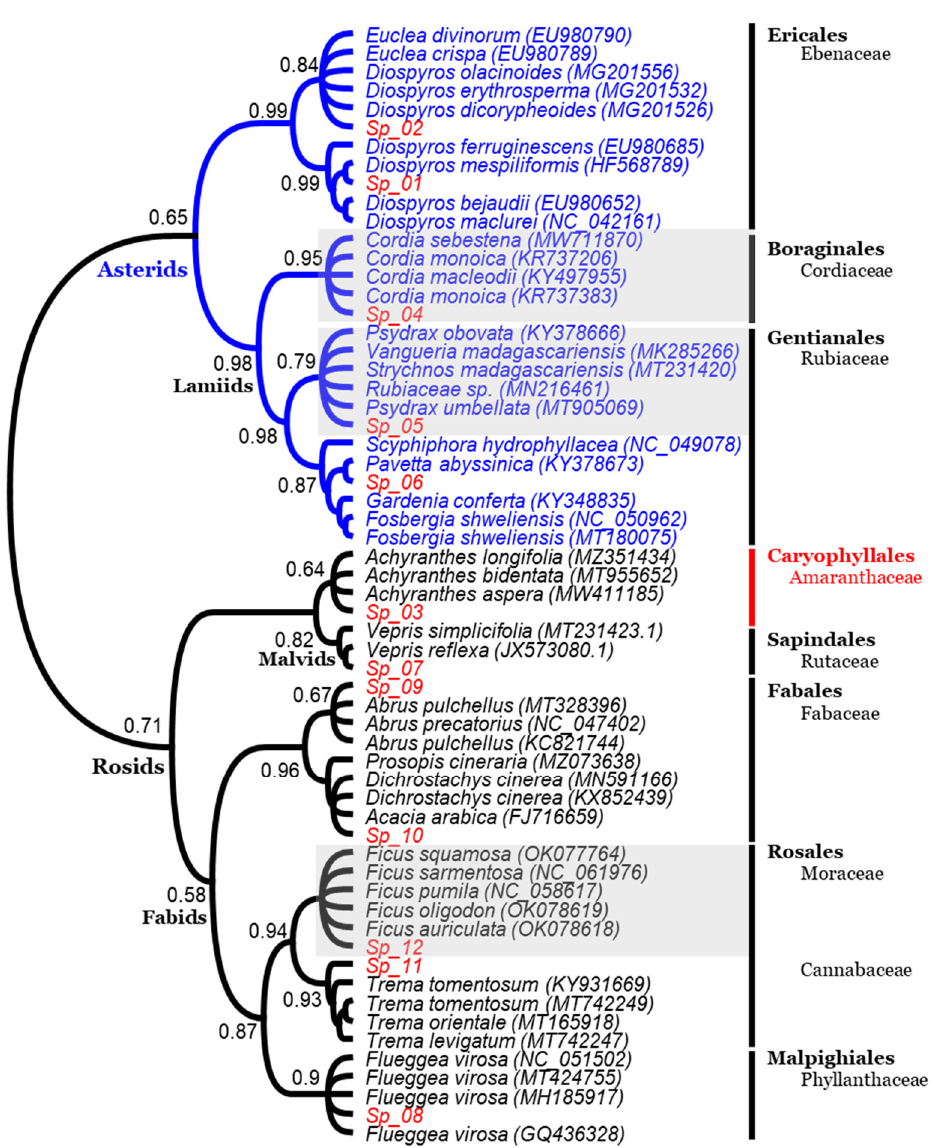
Figure 3. Maximum-likelihood phylogenetic tree based on rbcL gene. The taxonomical ranks are defined while the incongruences are highlighted with rectangular gray. Asterids clade is highlighted in blue, while the Rosids clade is highlighted in black. The species (03) with unexpected identification is ranked in red.